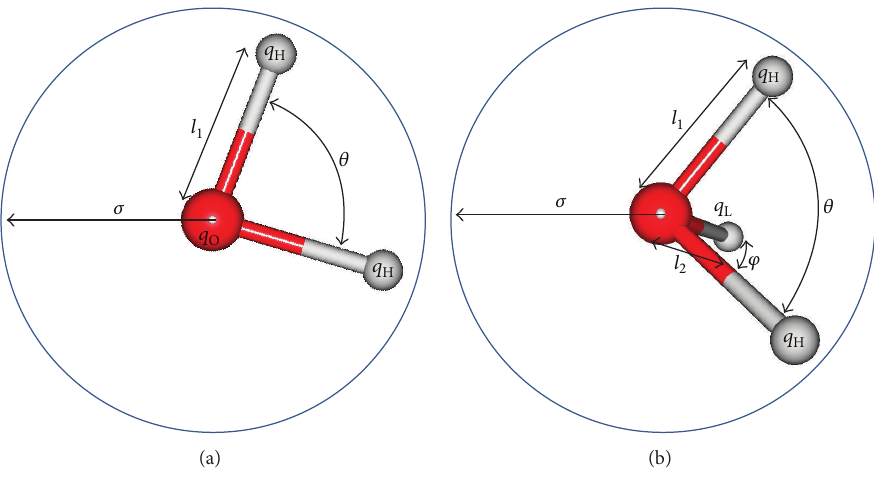
Figure 1: The 3-site (a) and 4-site (b) water models [22]. The labels are explained in Table 1.